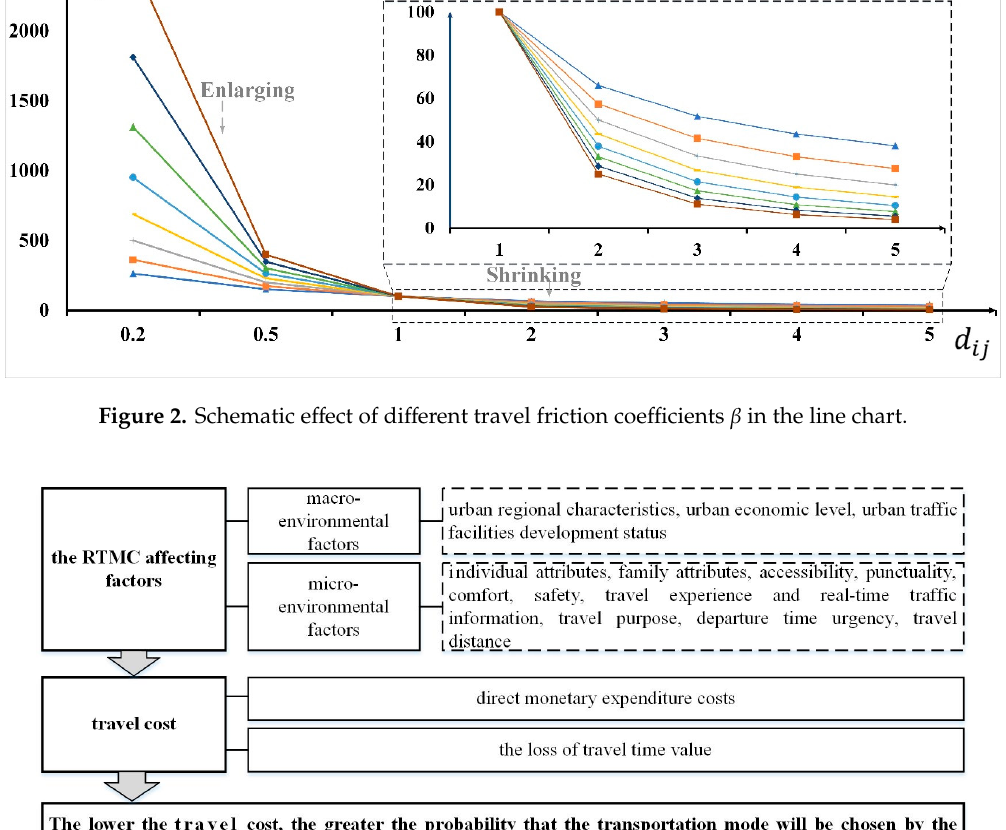
Figure 3. The RTMC theoretical model diagram.